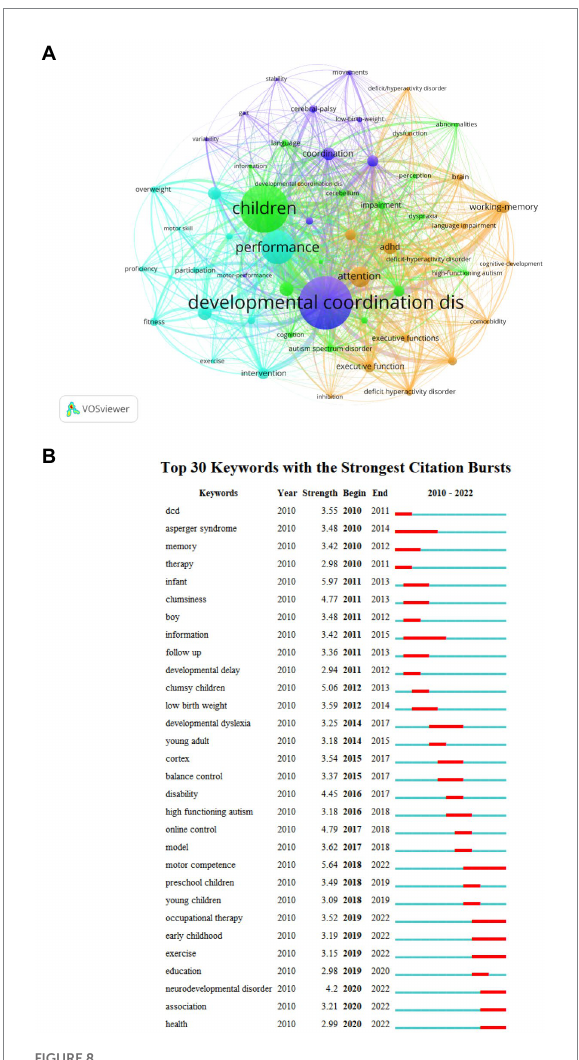
FIGURE 8 (A) Co-citation network visualization map of keywords based on VOSviewer; (B) Top 30 keywords with the strongest citation bursts based on CiteSpace. The red horizontal stripes represent the years with the most frequent keyword use. The green horizontal stripes represent the years with the most infrequent keyword